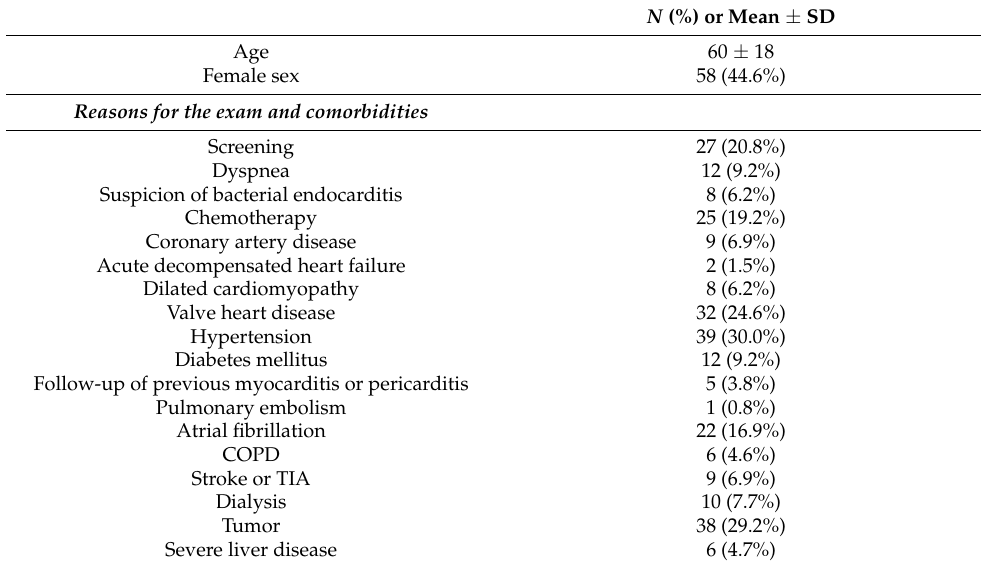
Table 1. Baseline clinical characteristics of the study population.